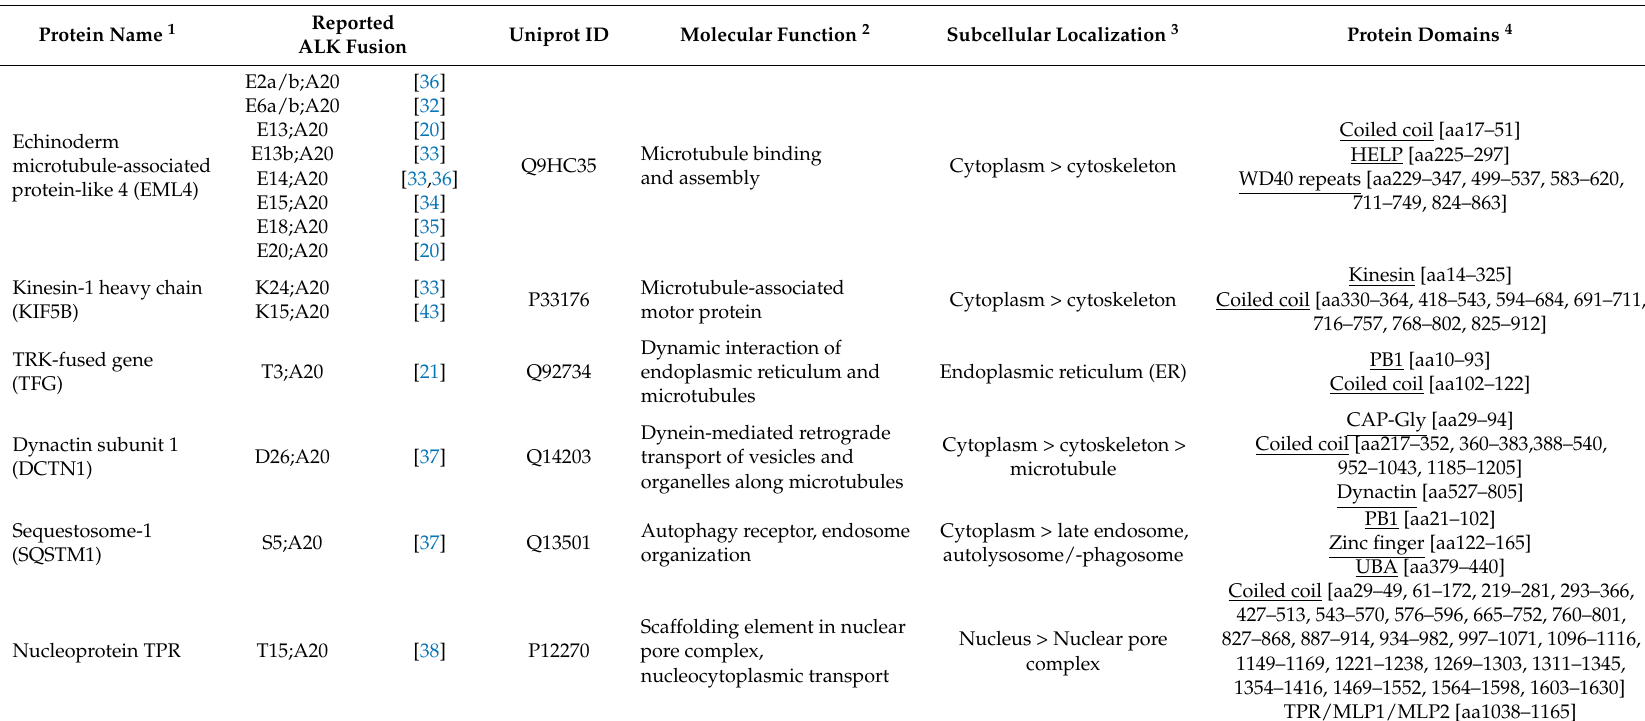
Table 1. Characterization of ALK fusion partners in